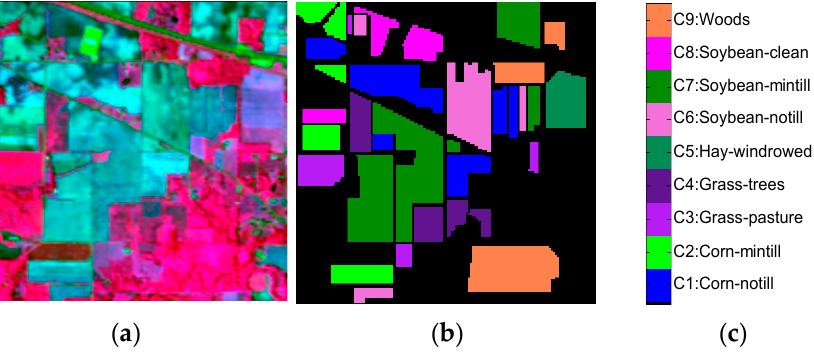
Figure 2. Indian Pines dataset with ( a ) original hyperspectral image, ( b ) ground truth, and ( c ) category names with labeled samples.